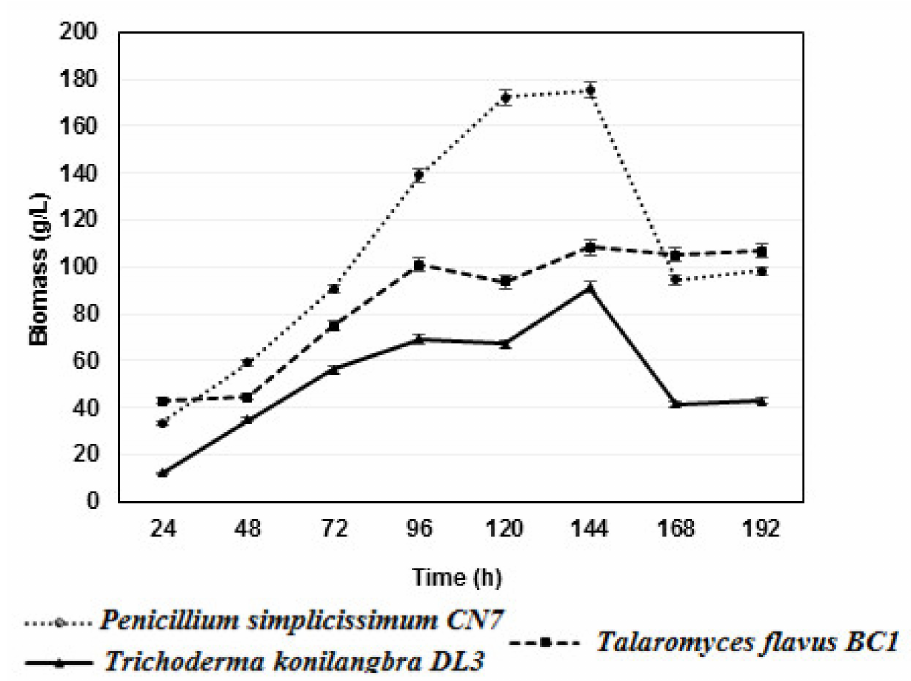
Figure 2. Growth dynamics of 03 rhizomatous fungal strains Penicillium simplicissimum CN7 , Talaromyces flavus BC1 , and Trichoderma konilangbra DL3